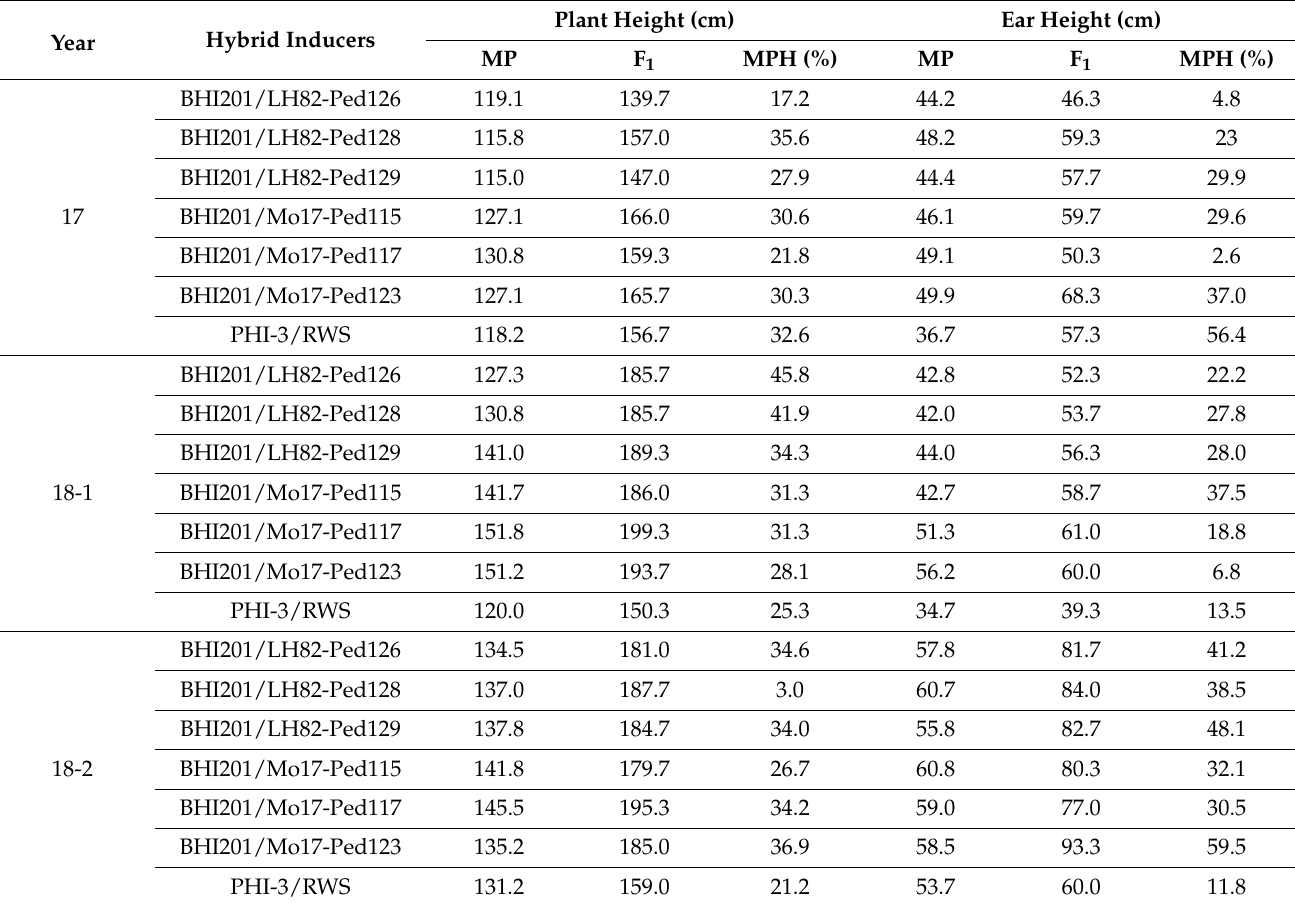
Table 3. Mid-parent (MP), hybrid mean (F1), and mid-parent heterosis (MPH) of hybrid haploid inducers on plant height (cm) and ear height (cm) between 2017 and